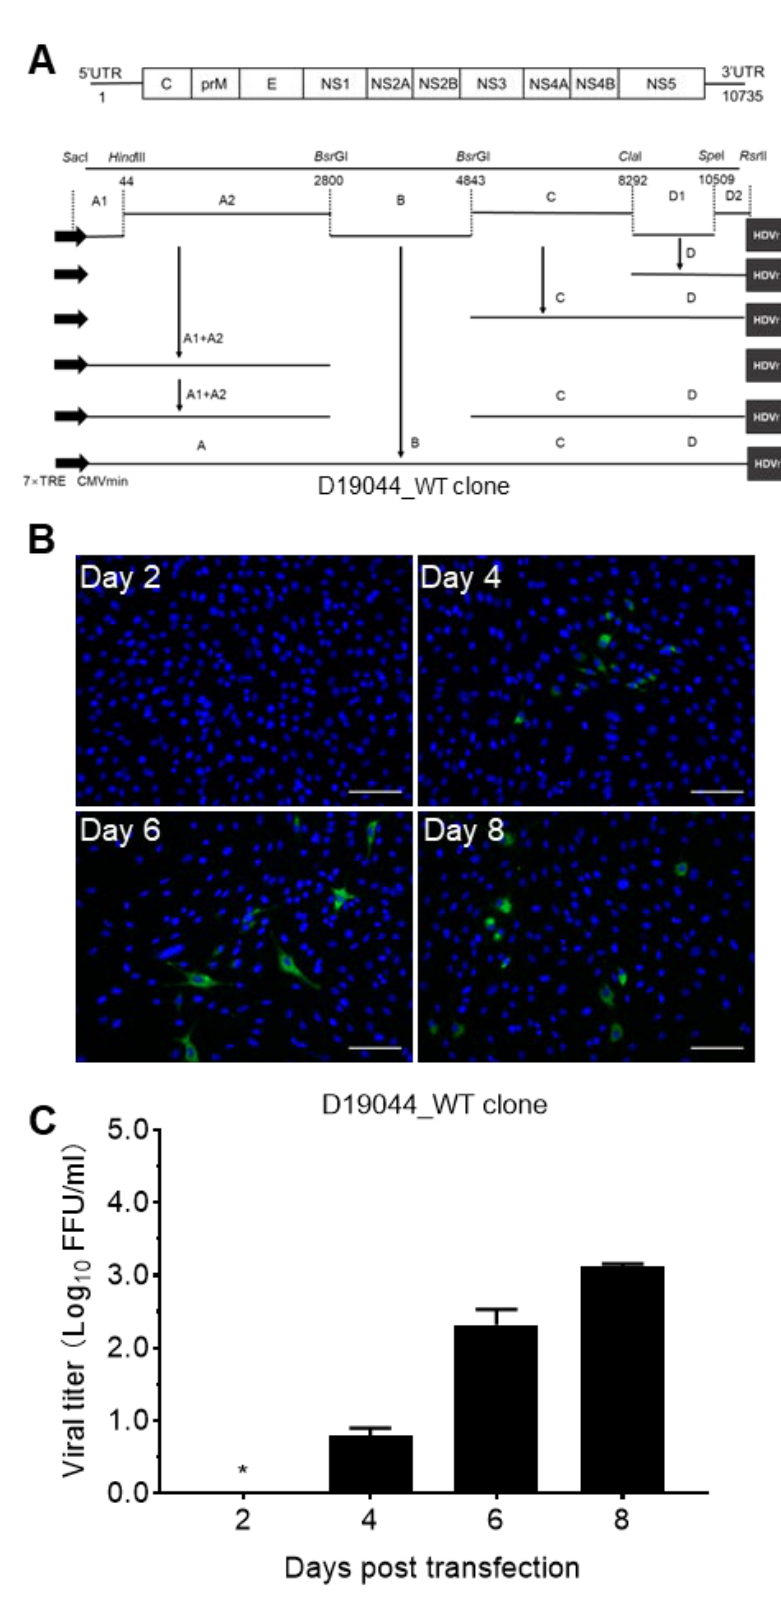
Figure 2. Construction of D19044 clone and its capacity to generate infectious virus particles. ( A ) Schematic diagram of construction of full-length D19044 cDNA clone. The full-length genome was illustrated and divided into four overlapping subgenomic fragments (A–D) for the